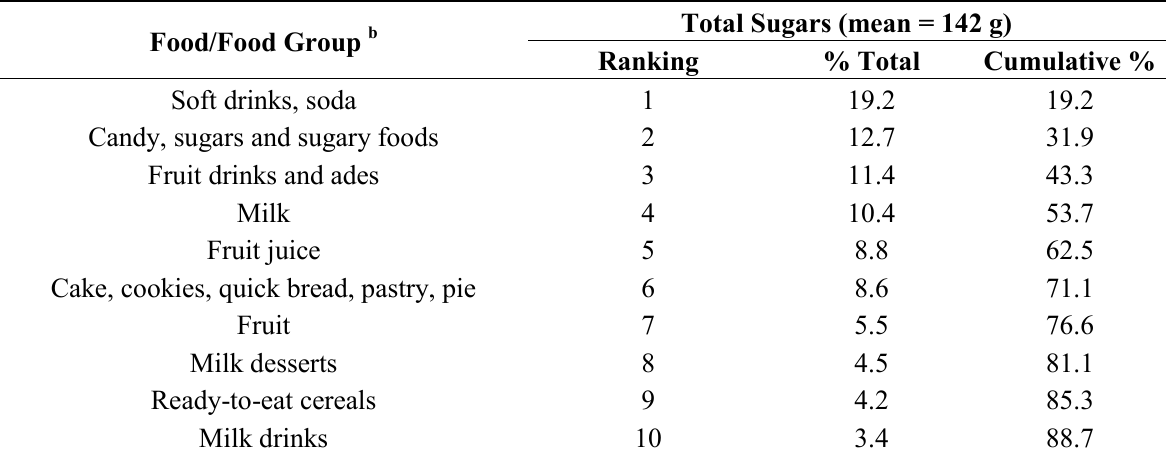
Table 4. Food/Food group sources of total sugars among US children aged 2–18 years (from NHANES 2003–2006) a